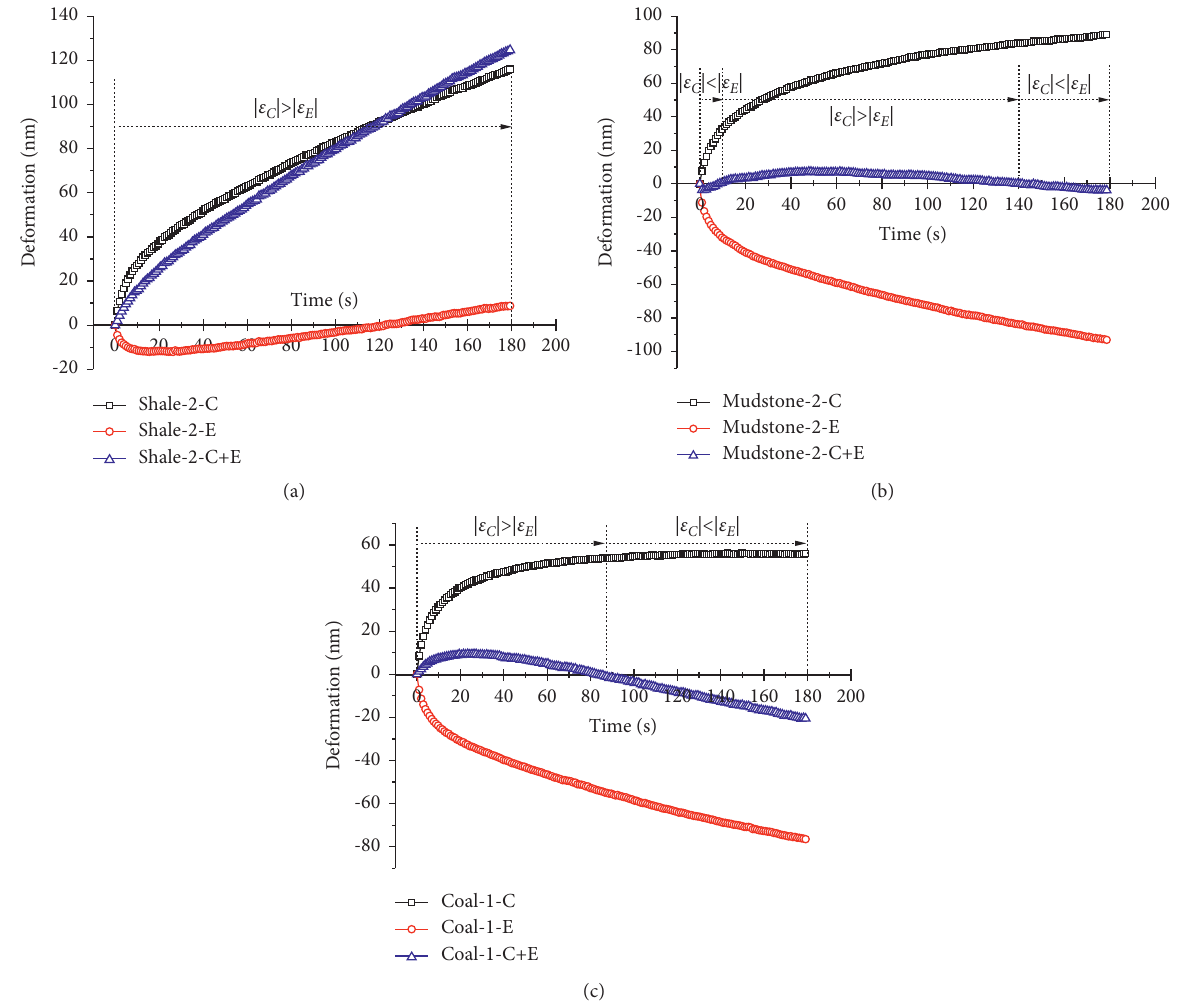
Figure 9: The overall strain of (a) shale-2, (b) mudstone-2, and (c) coal-1 by using the simplified Burgers